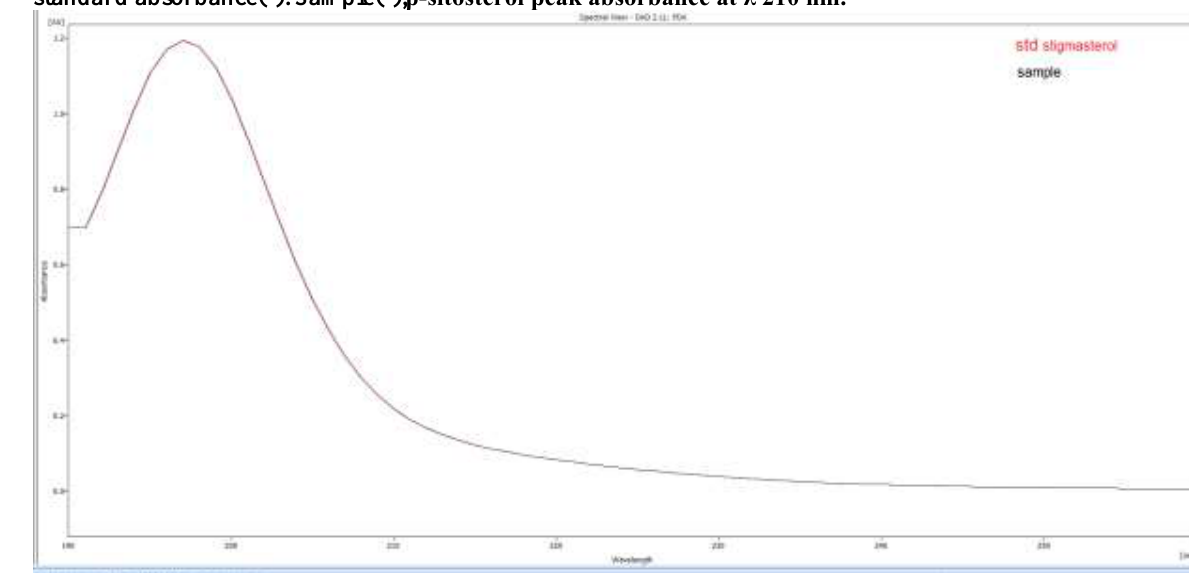
Figure 7. U.V. spectrum view using the diode array detector (DAD) for stigmasterol peak. STD, stigmasterol standard absorbance( - ). Sample(-), stigmasterol peak absorbance at λ 210 nm. For quantitative analysis, the calibration The concentration was calculated applying curve was plotted using the area under the curve a straight line equation, as illustrated in Figures 6 (AUC) versus four concentration levels of and 7. The calculated concentration of proposed stigmasterol and β-sitosterol standards from which stigmasterol and β-sitosterol (L1 and L2) in the Iraqi the concentration of the proposed stigmasterol and Lactuca serriola is shown in Table β-sitosterol (L1 and L2) in the hexane fraction.